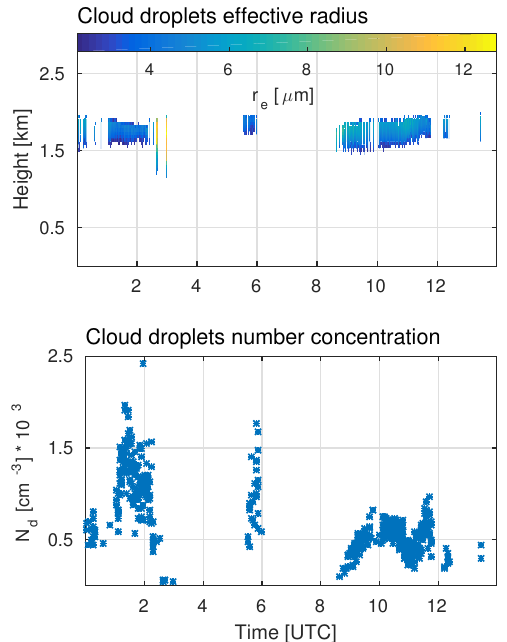
Figure 4. The time–height cross section of the cloud droplet ef- fective radius ( r e ) derived from the WACR and the MWR (Eq. 10) and the cloud droplet number concentration ( N d ) calculated from Eq. (11) from 29 November 2009. Data are only retrieved in the time steps when the data selection criteria are